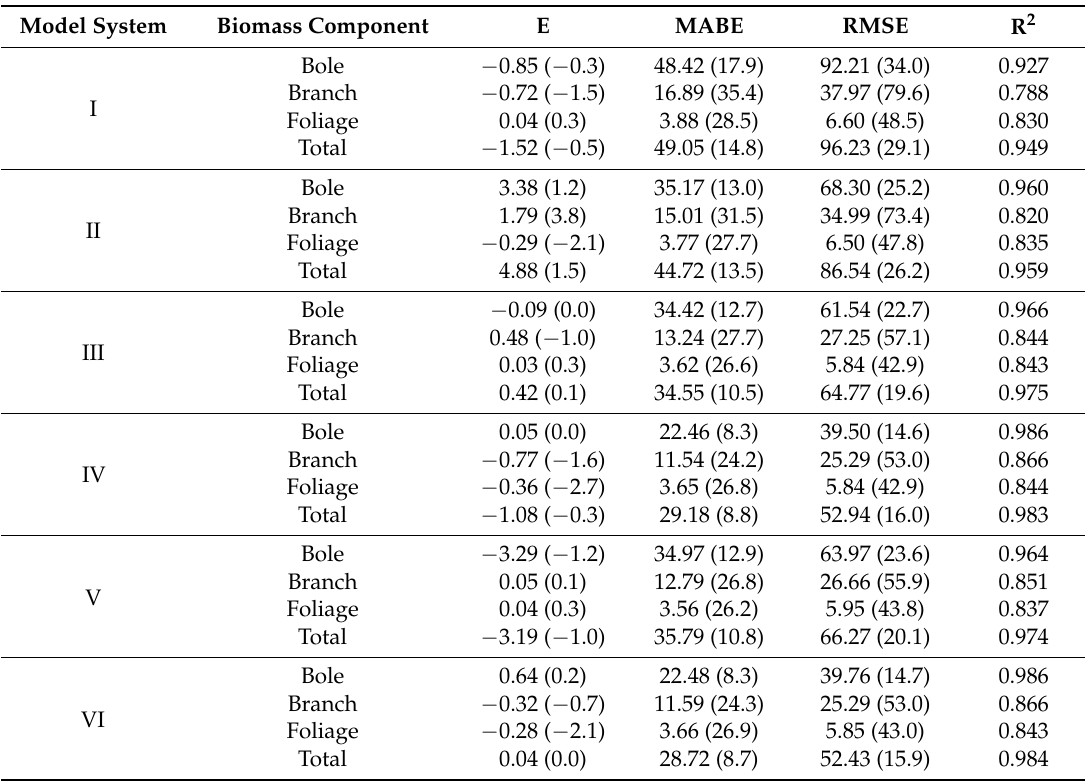
Table 10. Leave-one-out (LOO) cross-validation results for each biomass component in the additive biomass equation